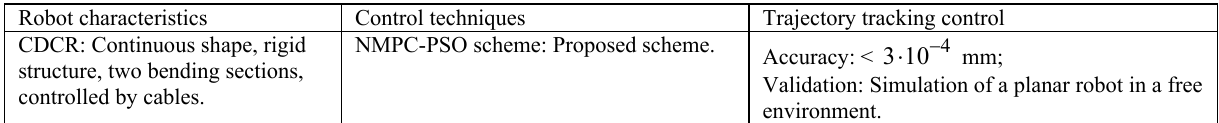
Table 3. Some contributions in the control of continuum